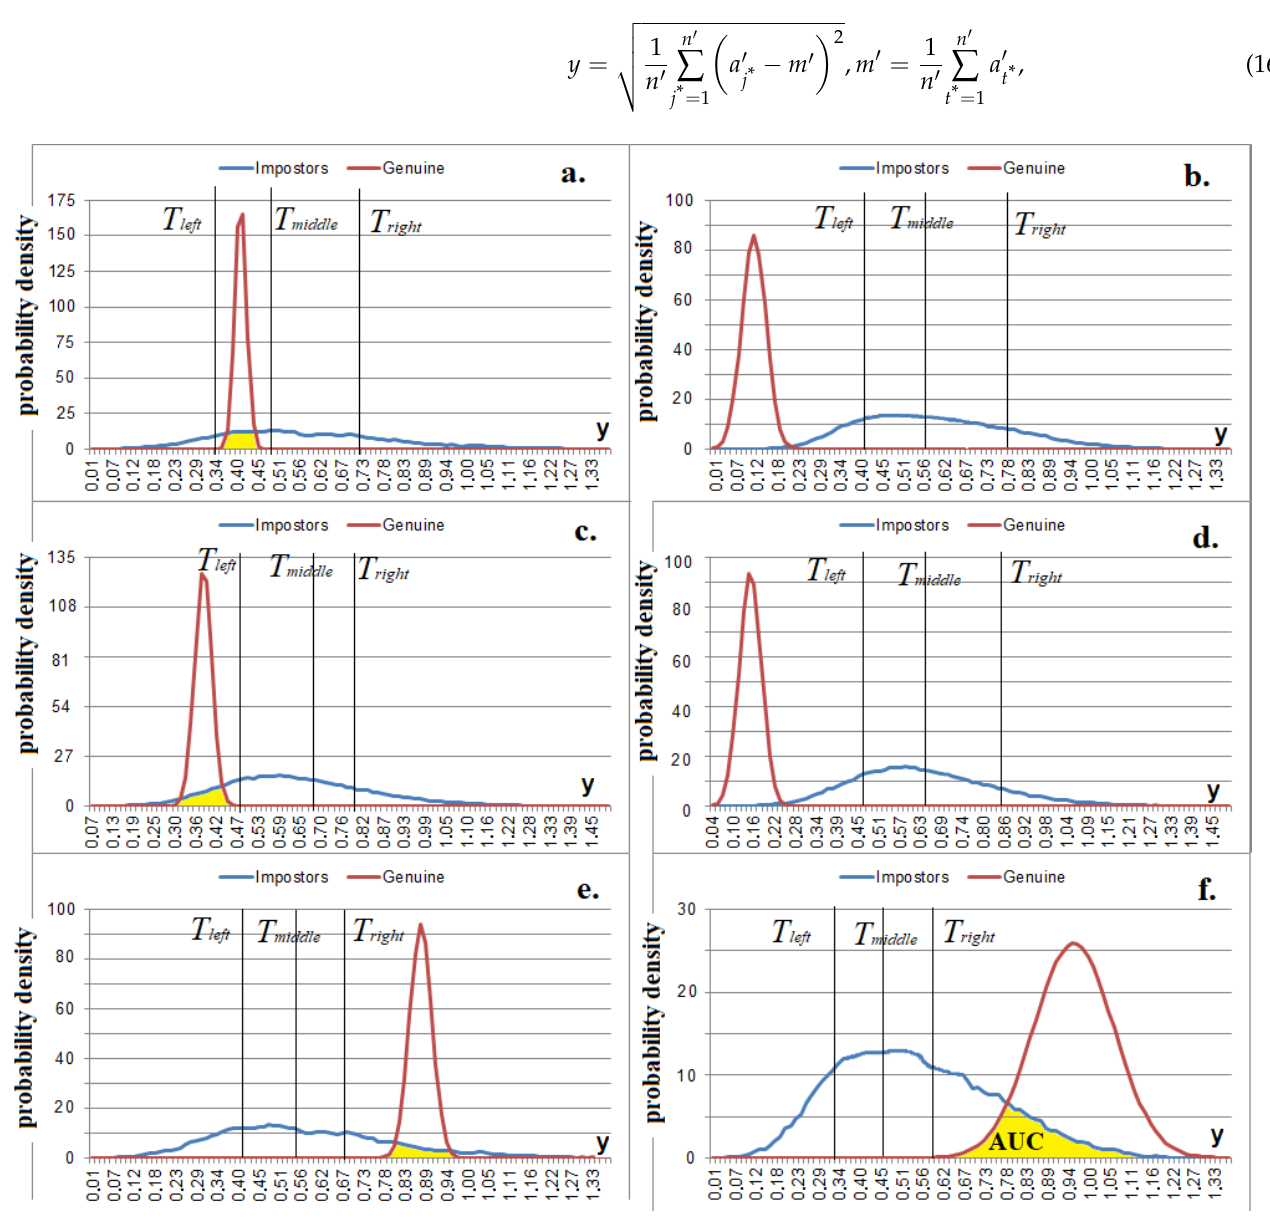
Figure 9. Plots of probability densities of measured values in (16) after the mapping in (12) at p = 1, I ≈1.75 bits ( a ) for all classes where 1> C j,t > 0.95, n ’ = 10; ( b ) for all classes where −1 < C j,t < −0 .95, n ’ = 10;